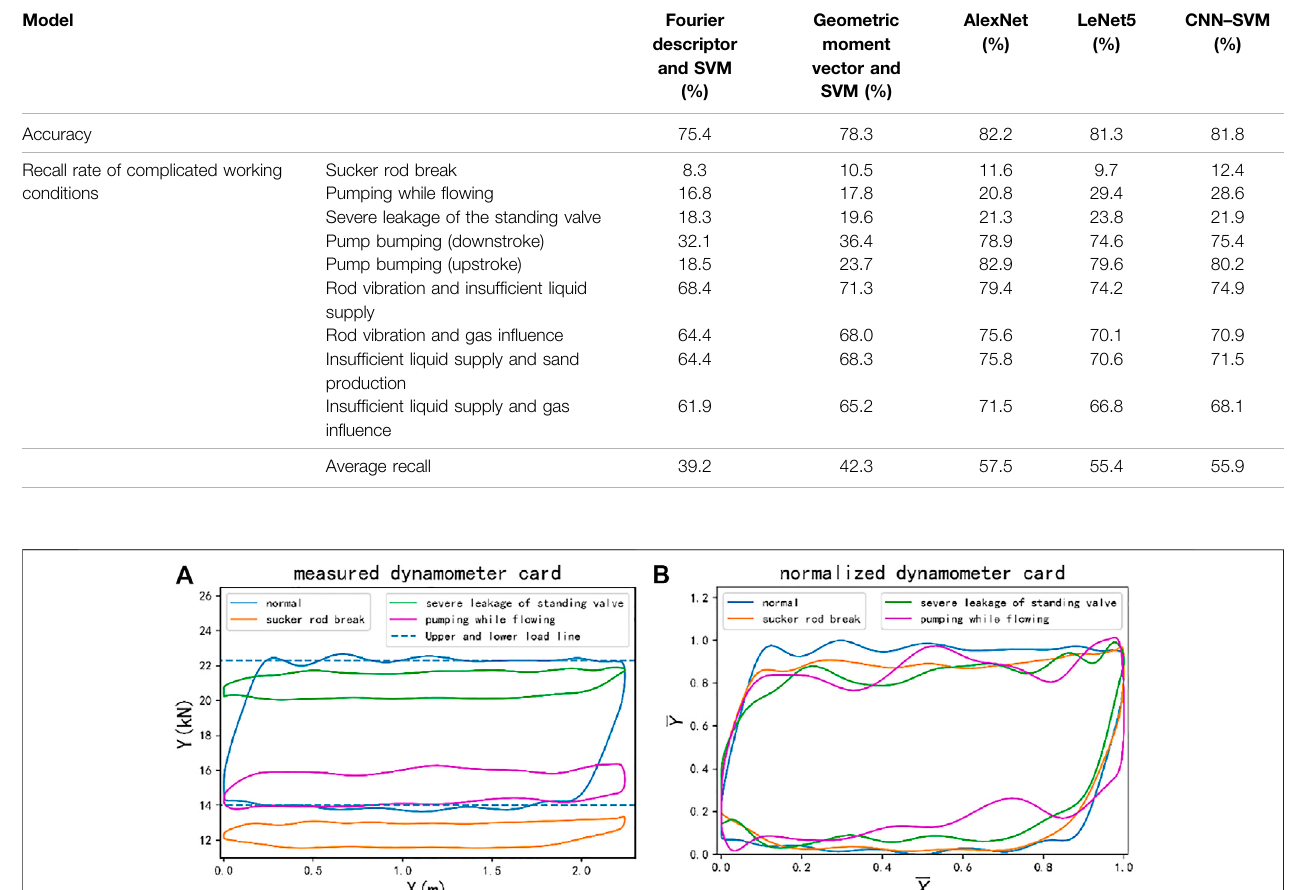
TABLE 1 | Performance test results of each mainstream model.